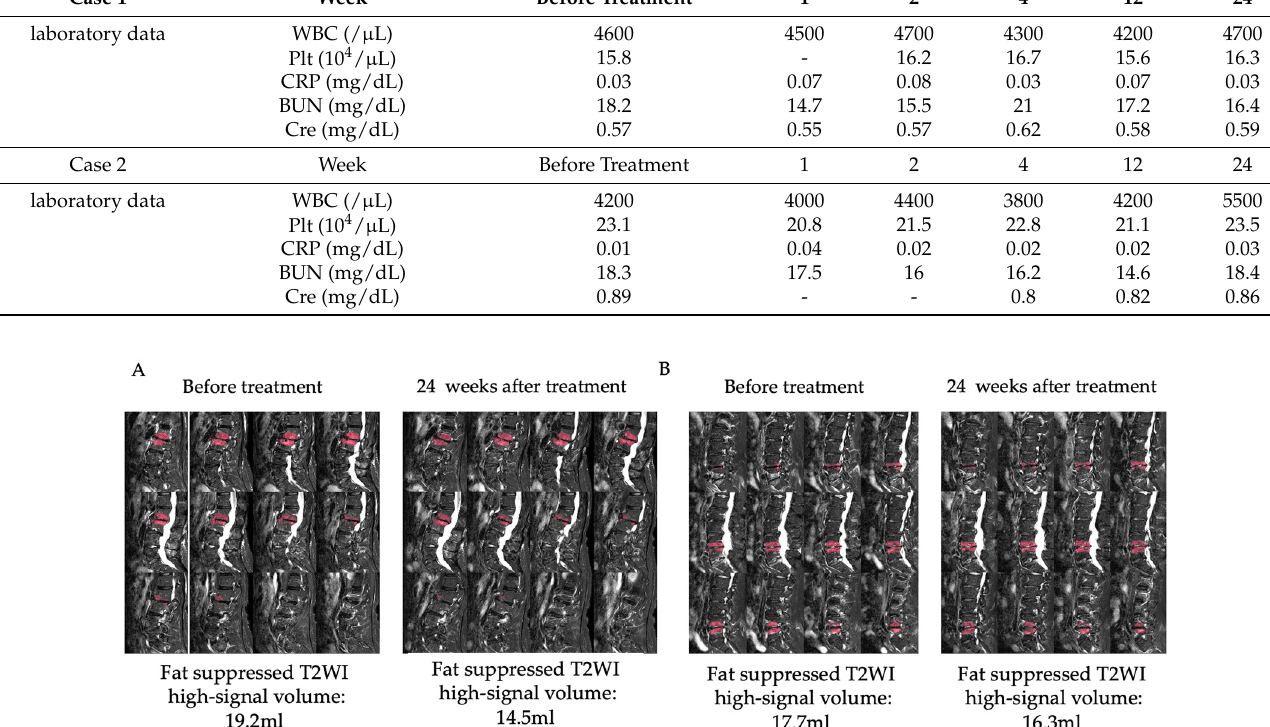
Figure 4. Images of fat suppressed T2WI before and 24 weeks after PRP administration in case 1 and case 2. ( A , B ) are images of fat suppressed T2WI before and 24 weeks after PRP administration in case 1 and case 2, respectively; fat suppressed T2WI high volume (red color regions) decreased from 19.2 mL to 14.5 mL in case 1 and from 17.7 mL to 16.3 mL in case 2.